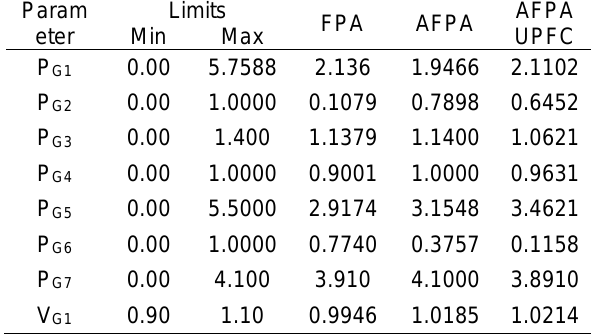
Figure 6. Bus voltages for different OPF methods Table 9. OPF results with Power loss as an